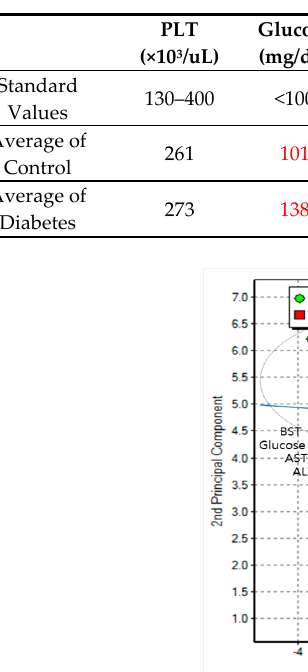
Figure 2. Measurement system using experimental works. Table 1. Clinical data for the participants in study.